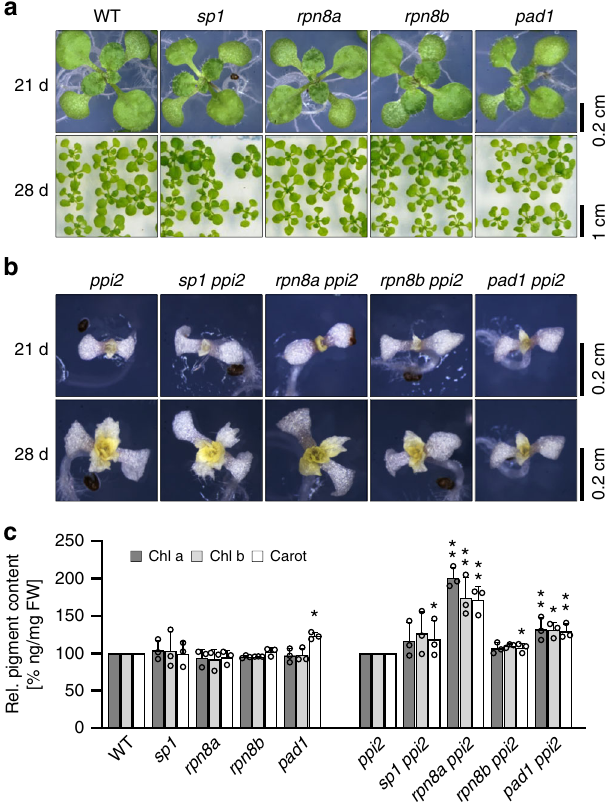
Fig. 1 Characterization of plant growth for the indicated lines. a Wildtype (WT), sp1 , rpn8a , rpn8b, and pad1 lines and b ppi2 , sp1 ppi2 , rpn8a ppi2 , rpn8b ppi2, and pad1 ppi2 lines were grown for 21 and 28 days under growth light conditions. c Pigment content of four-week-old WT, sp1 , rpn8a , rpn8b , pad1 , ppi2 , sp1 ppi2 , rpn8a ppi2, rpn8b ppi2, and pad1 ppi2 plants were determined as described in the Methods section and statistically evaluated ( n = 3 × 6 in case of green plants, n = 3 × 30 in case of albino plants). Signi fi cant differences are highlighted by one ( p -value < 0.05, T -test, two-sided) or two stars ( p -value < 0.005, T -test, two-sided) on top of the columns. Error- bars represent